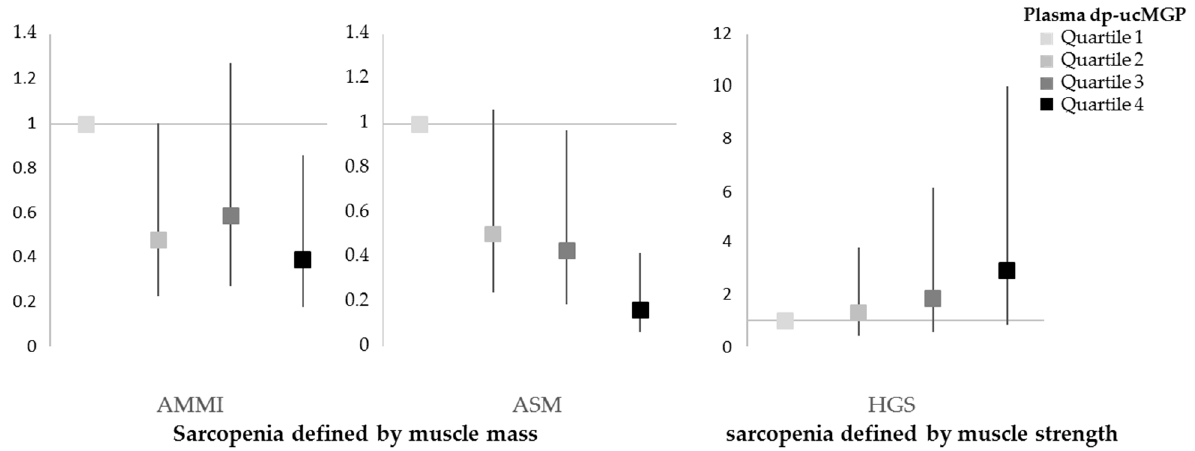
Figure 4. Odds ratios with 95% confidence intervals for prevalent sarcopenia features according